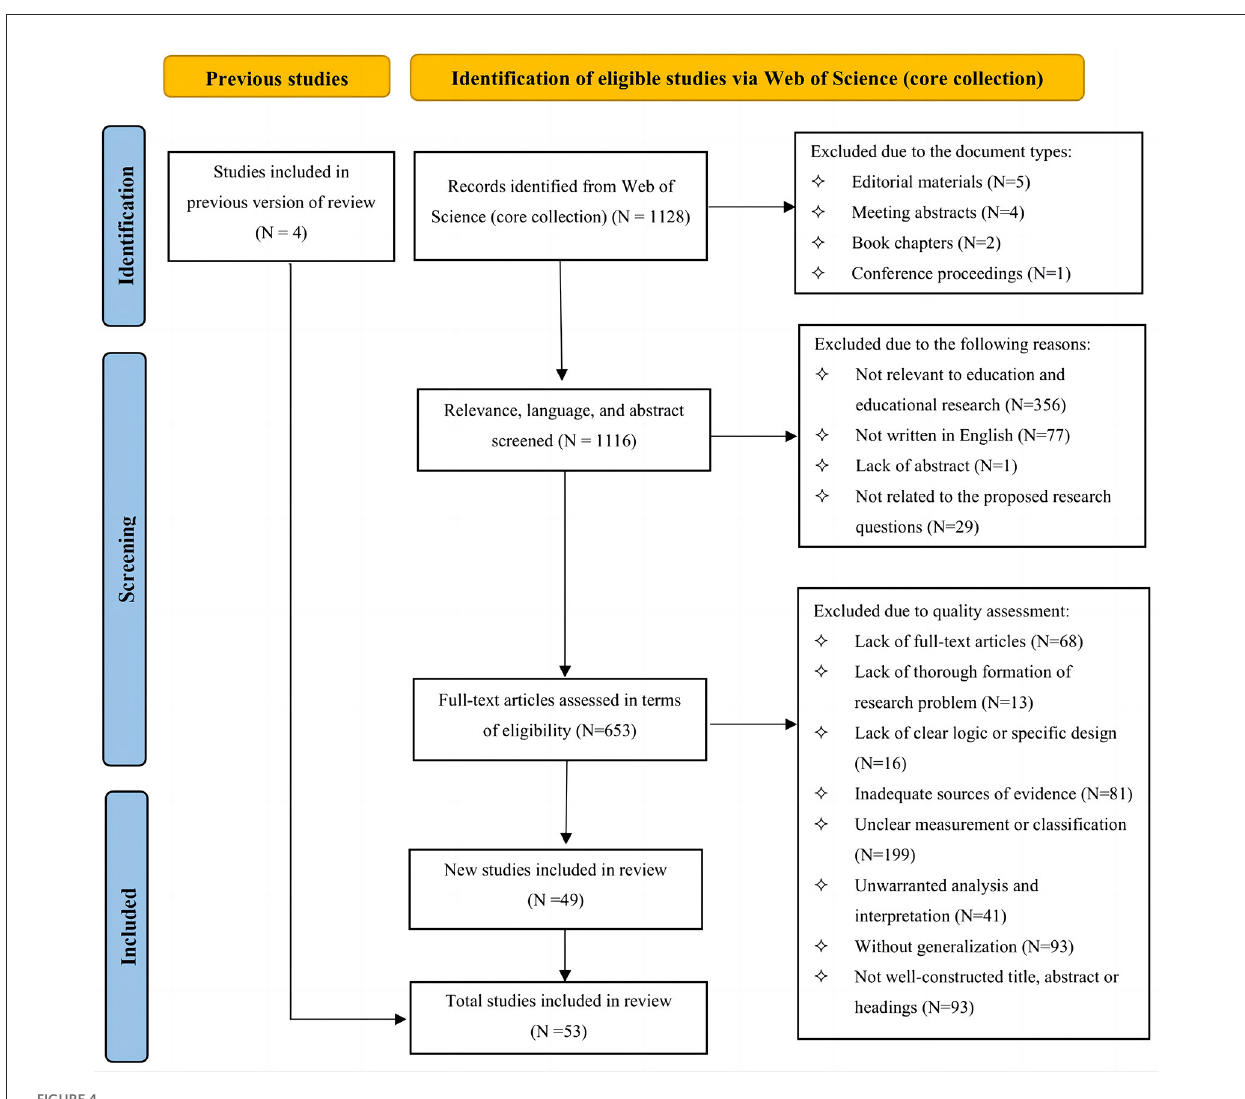
FIGURE4 The PRISMA flow diagram of literature